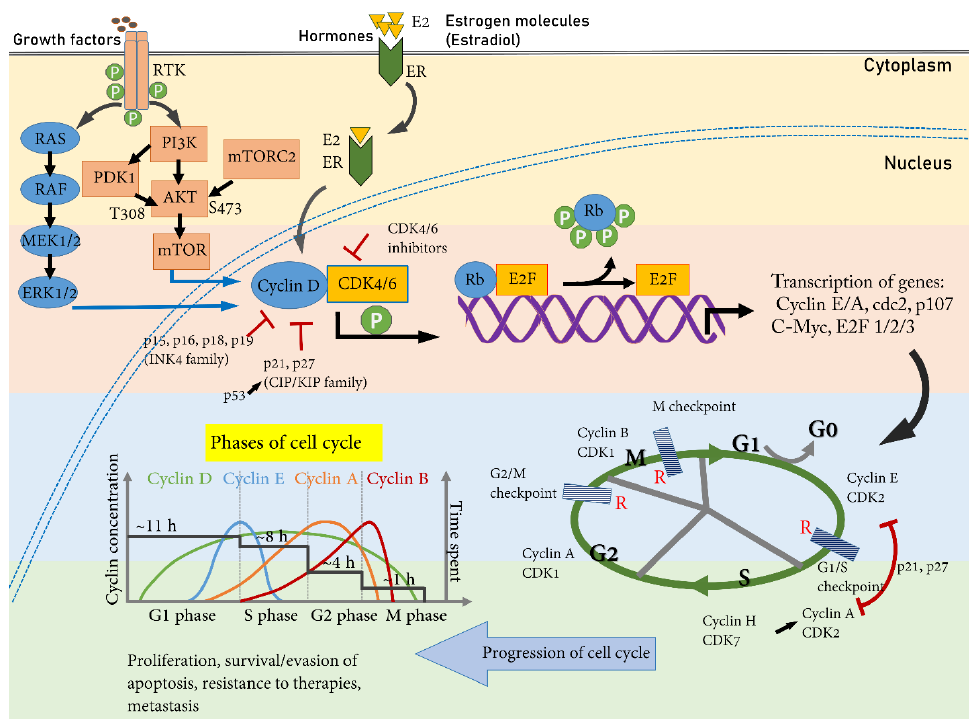
Figure 1. Cell cycle progression via upregulation of Cyclin D and Rb phosphorylation. Cyclin D is a downstream target of the estrogen receptor. Upon estrogen (estradiol β , E2) reception, ER translocates from cell membrane to nucleus and increases the expression of cyclin D through activation of target genes. Cyclin D is also upregulated by MAPK (via ERK1/2) and PI3K (via mTOR) signaling upon growth factor stimuli. MAPK and PI3K cooperate to increase the transcription of Cyclin D. The binding of Cyclin D with its cognate partner CDK 4/6 phosphorylate Rb causes the release of E2F (E2F activation—a prerequisite step) and activates cell cycle responsive genes for progressing into the S phase. The entry into the successive phase of the cell cycle is guarded via restriction points, which check the appropriateness and readiness of the cell for cell cycle progression and division. The level of cyclins “oscillate” at different phases of the cell cycle and binds with their CDK partner in a time-dependent manner. The duration of each phase of the cell cycle varies, with the maximum time spent in the G1 phase and the minimum time spent in the M phase (shown for a cycle time of 24 h